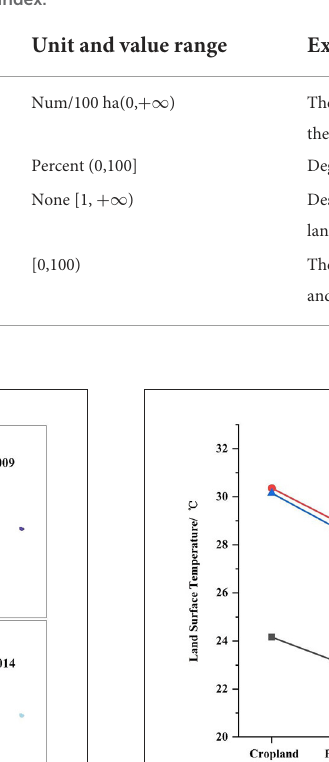
TABLE 2 Calculation method and description of landscape index.